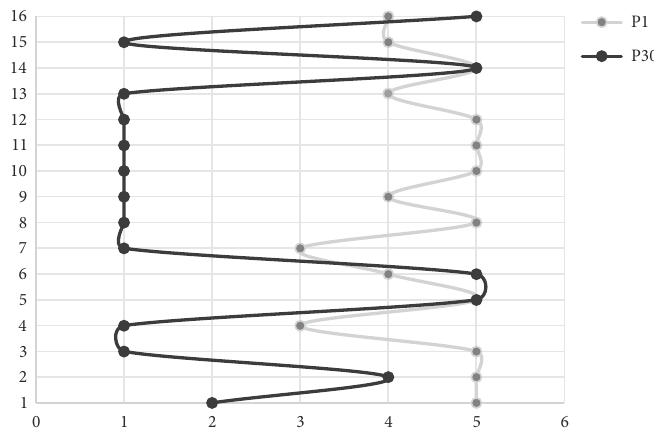
Figure 3. Extreme results of selected Table 6. Correlation coefficients of r -Pearson between the analysed areas